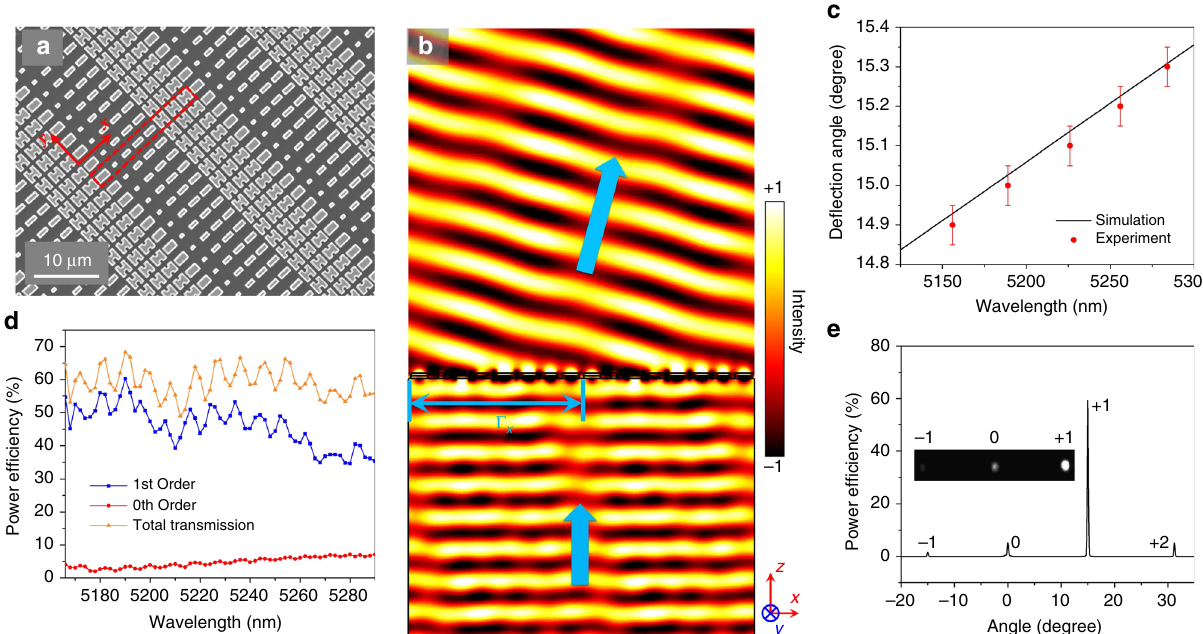
Fig. 3 Characterization of diffractive beam de fl ector. a Top-view SEM image of the HMS beam de fl ector: the red box marks the unit cell; b simulated electric fi eld pro fi le when a plane wave at 5.2 μ m wavelength is incident upon the metasurface from the substrate side, clearly showing the beam de fl ection effect; c simulated and experimentally evaluated wavelength dependence of the beam de fl ection angle, error bar originated from accuracy (±0.1) of measurement setup; d experimentally measured spectra for total transmission (sum of all transmissive diffraction orders), 1st diffraction order (the blazed order) and 0th order (specular transmission) of the de fl ector; e angle-dependent output intensity from the device measured at 5.19 μ m wavelength. Inset shows an infrared image of the diffracted beams at the same